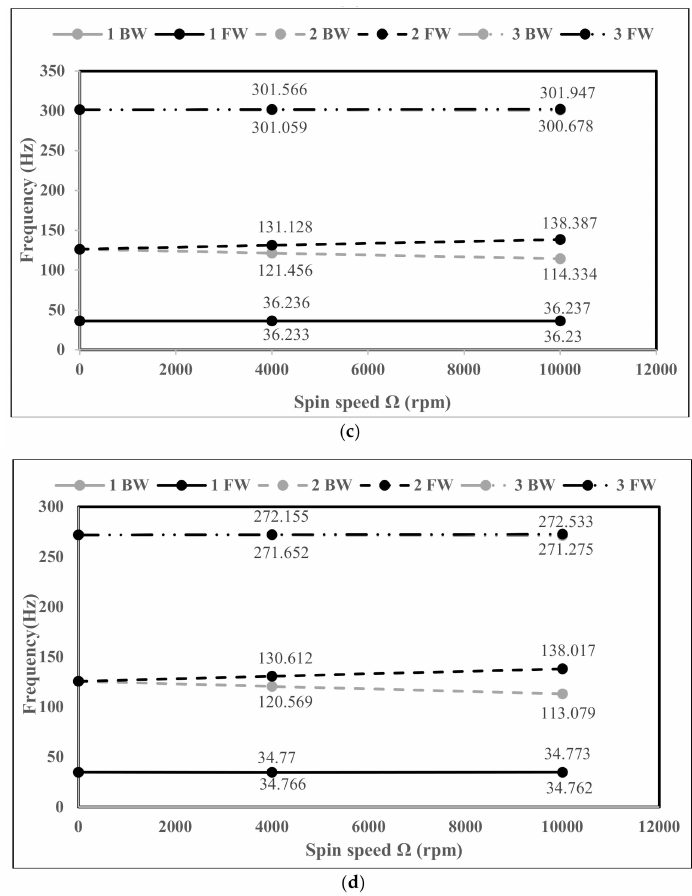
Figure 10. ( a ) Campbell diagram of an FG rotor–bearing system for k = 0.5 and ∆ T = 0, without porosity. ( b ) Campbell diagram of a porous FG rotor–bearing system for k = 0.5, α = 0 and ∆ T = 600. ( c ) Campbell diagram of a porous FG rotor–bearing system for k = 0.5, α = 0.1 and ∆ T = 0. ( d ) Campbell diagram of a porous FG rotor–bearing system for k = 0.5, α = 0.1 and ∆ T =